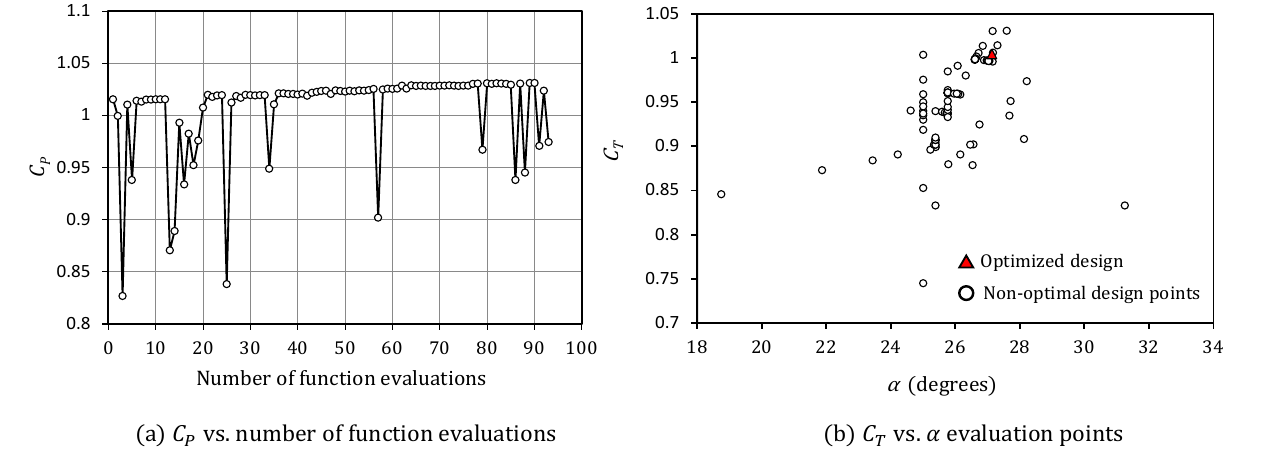
Figure 3. Optimization of C P using Powell’s method for z/c fixed at 0.05. The red triangle denotes the optimized solution.